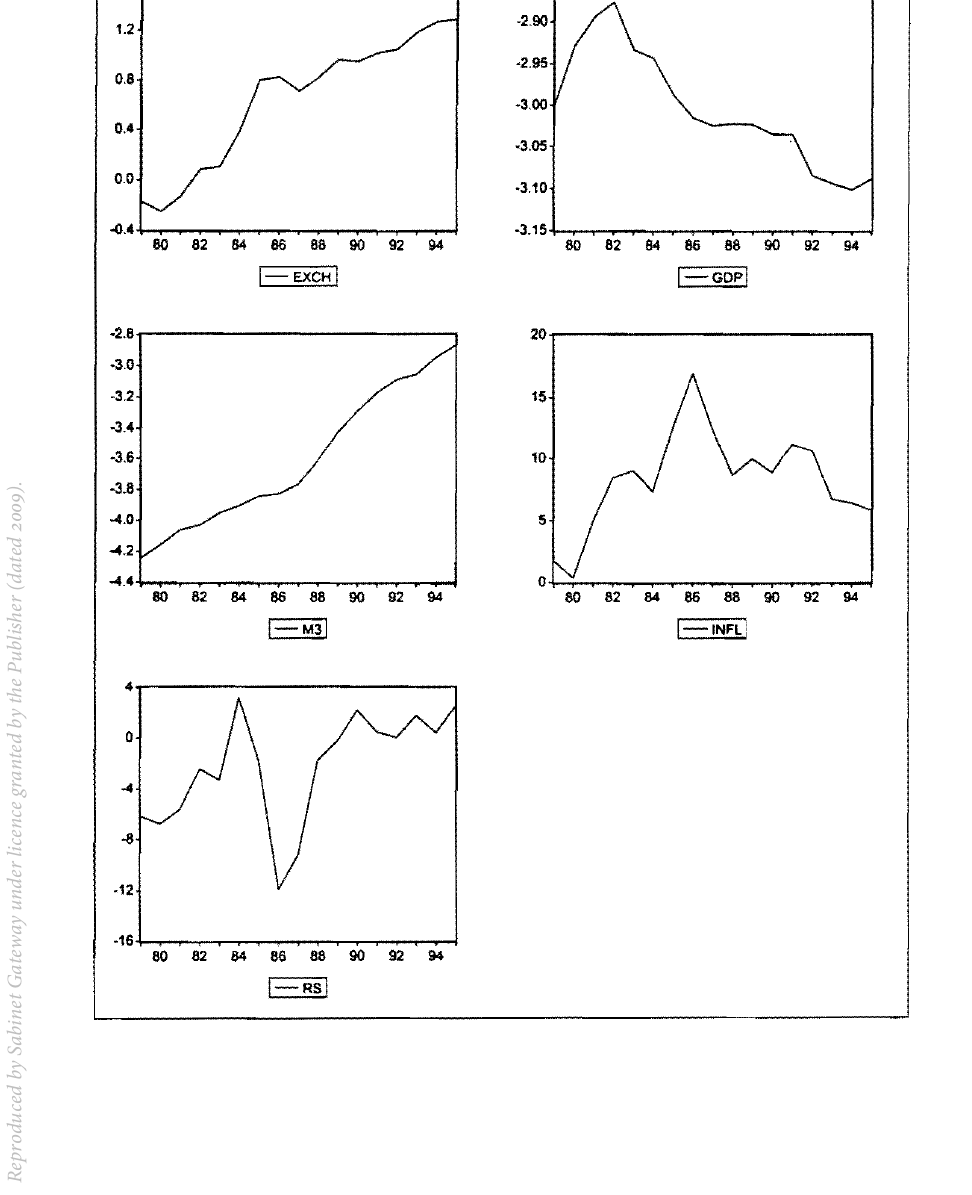
Data plots for EXeH, GDP, MJ, INFL and RS: 1979 -